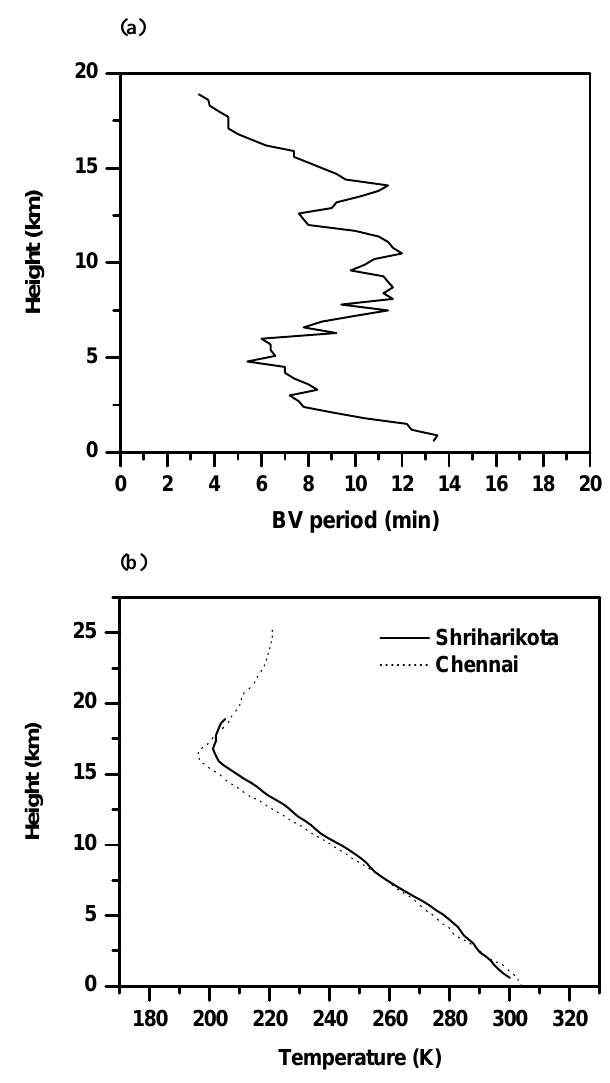
Fig. 6. Height profiles of (a) Brunt-V¨ais¨al¨a period and (b) tempera- ture on 4 September 2002 over Shriharikota (09:00UT). The dotted line represents temperature measured by the radiosonde at Chennai (12:00UT), 100km to the south, and the solid line represents tem- perature estimated from Eq. (3) by using N 2 profile computed from present